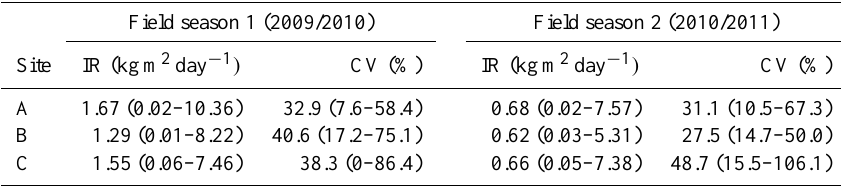
Table 4. Mean and range of daily sediment < 2mm infiltration rate (IR) during the two seasons at the three sites and of the coefficient of variation (CV) of the weekly values within the six samplers per